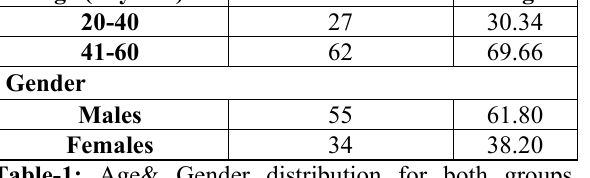
Table-1: Age& Gender distribution for both groups (n=89).